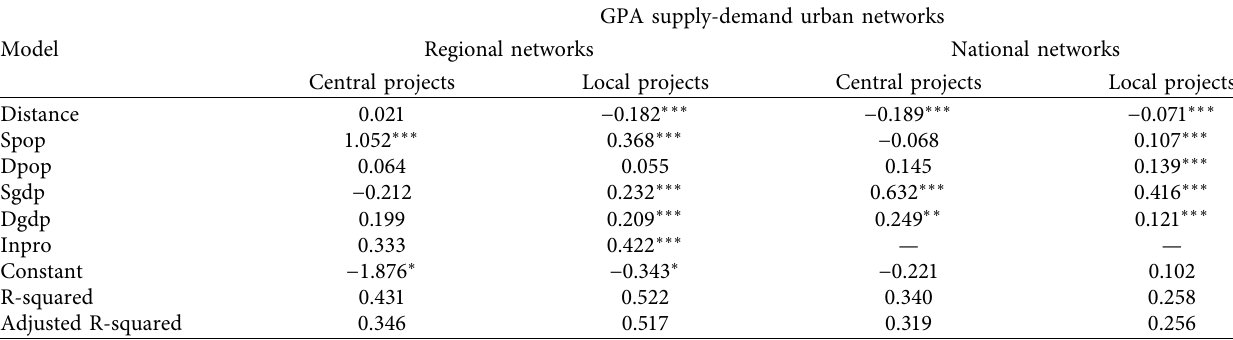
Table 8: Regression analysis